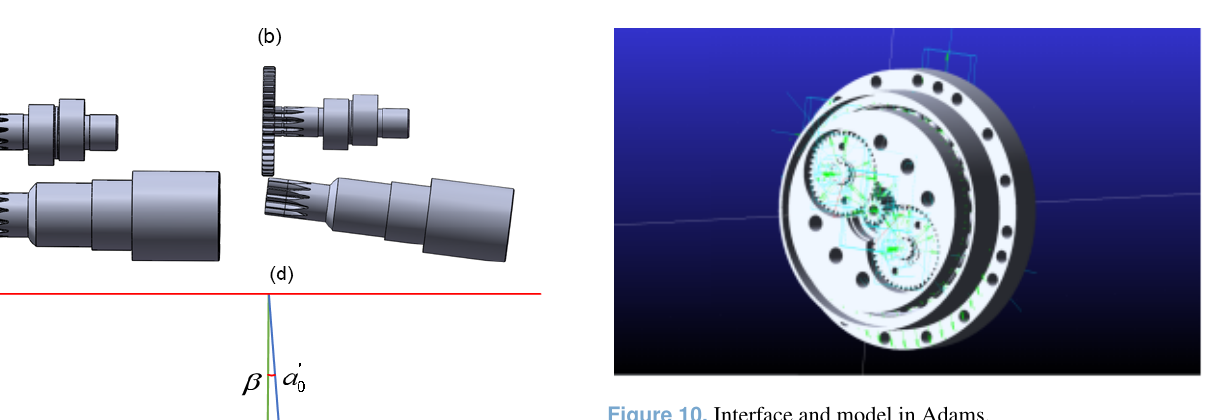
Figure 10. Interface and model in